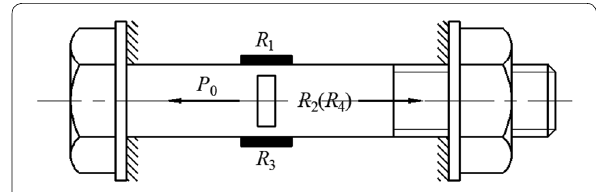
Figure 6 Relationship between torque and nut rotation angle [10] Figure 7 Resistance strain gauge detection assembly